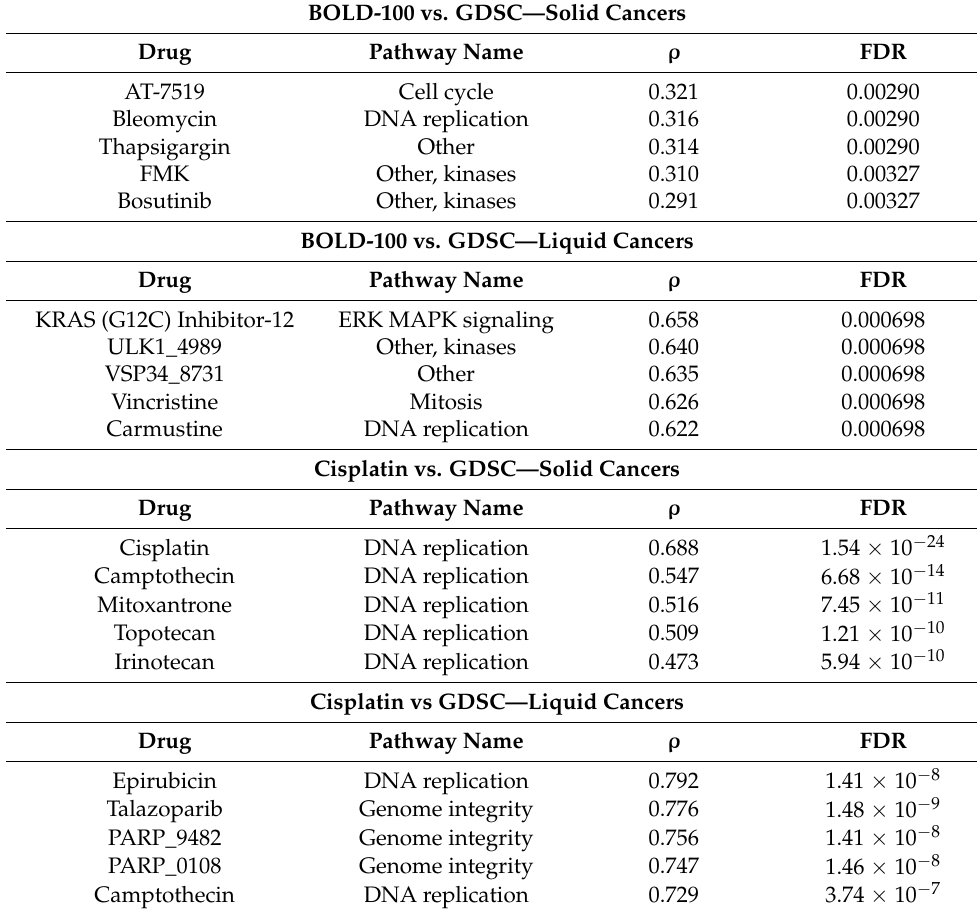
Table 1. Spearman correlation results between sensitivity profiles of anticancer compounds from the Genomics of Drug Sensitivity in Cancer (GDSC) database and BOLD-100 and cisplatin profile from the cell panel. Associated pathway annotated for each drug was obtained from the GDSC